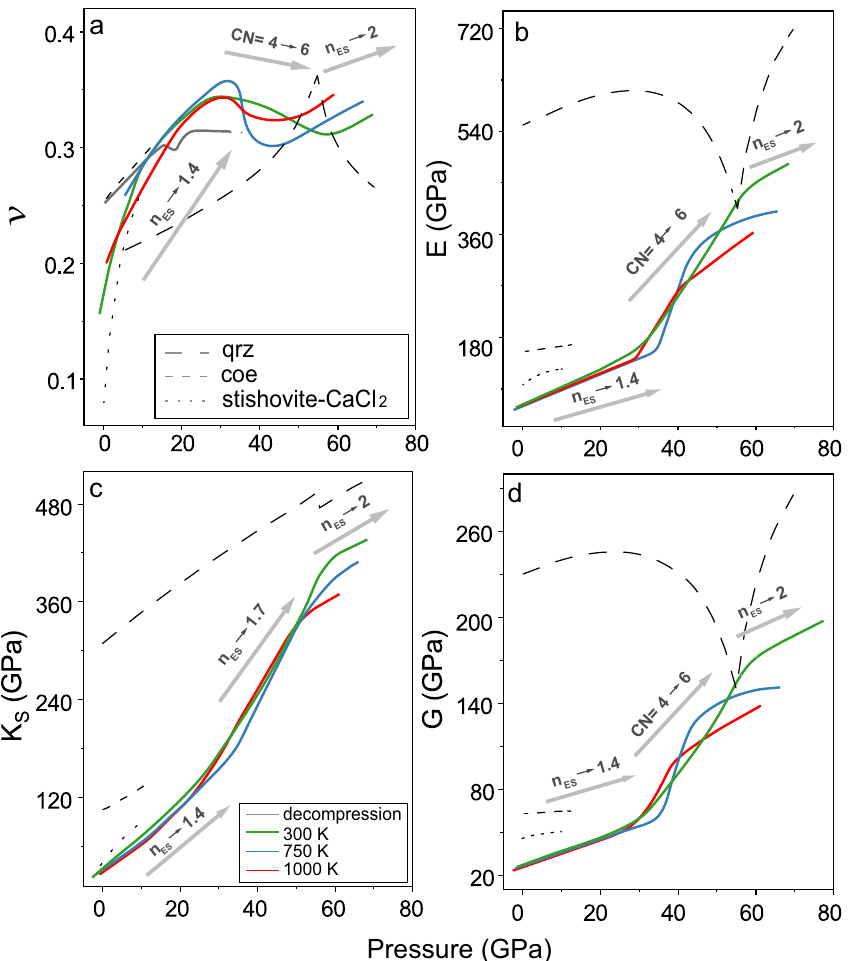
Figure 4. Elastic moduli of SiO 2 glass and crystals. ( a ) Poisson’s ratio ( ν ); ( b ) Young’s modulus ( E ); ( c ) bulk modulus ( K S ); ( d ) shear modulus ( G ). Green lines: 300 K; blue lines: 750 K; red lines: 1000 K; grey solid line: decompression results. Grey dotted lines: quartz 51 ; grey short-dashed lines: coesite 52 ; grey dashed lines: stishovite and CaCl 2 -type SiO 2 46 . CN: coordination number; n ES : a total number of shared edges per polyhedron. Arrows with CN on the top indicated that the CN increasing from 4 to 6 was the major reason of the moduli increasing, while the arrows with n ES on the top indicated the moduli increasing was mostly driven by the n ES